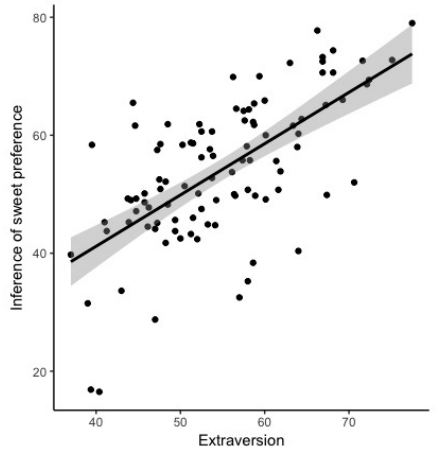
Figure A3. Scatterplot of the relationship between likability and inferences of sweet preference.